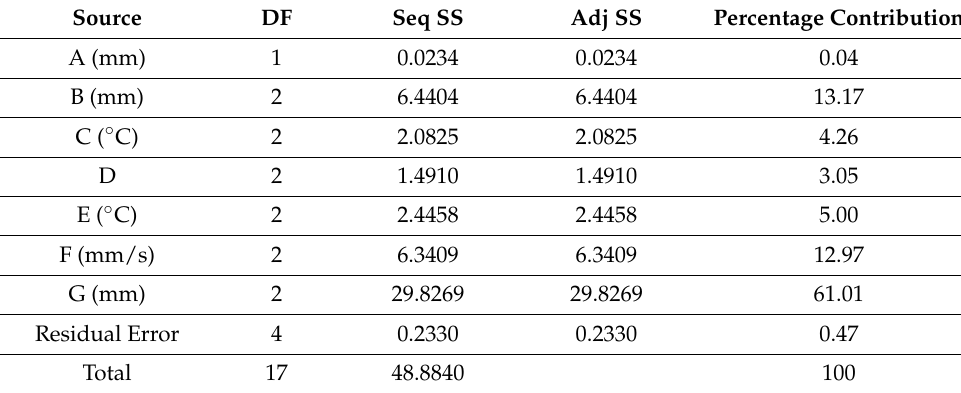
Table 8. ANOVA Table for the Rq-ABS polymer.